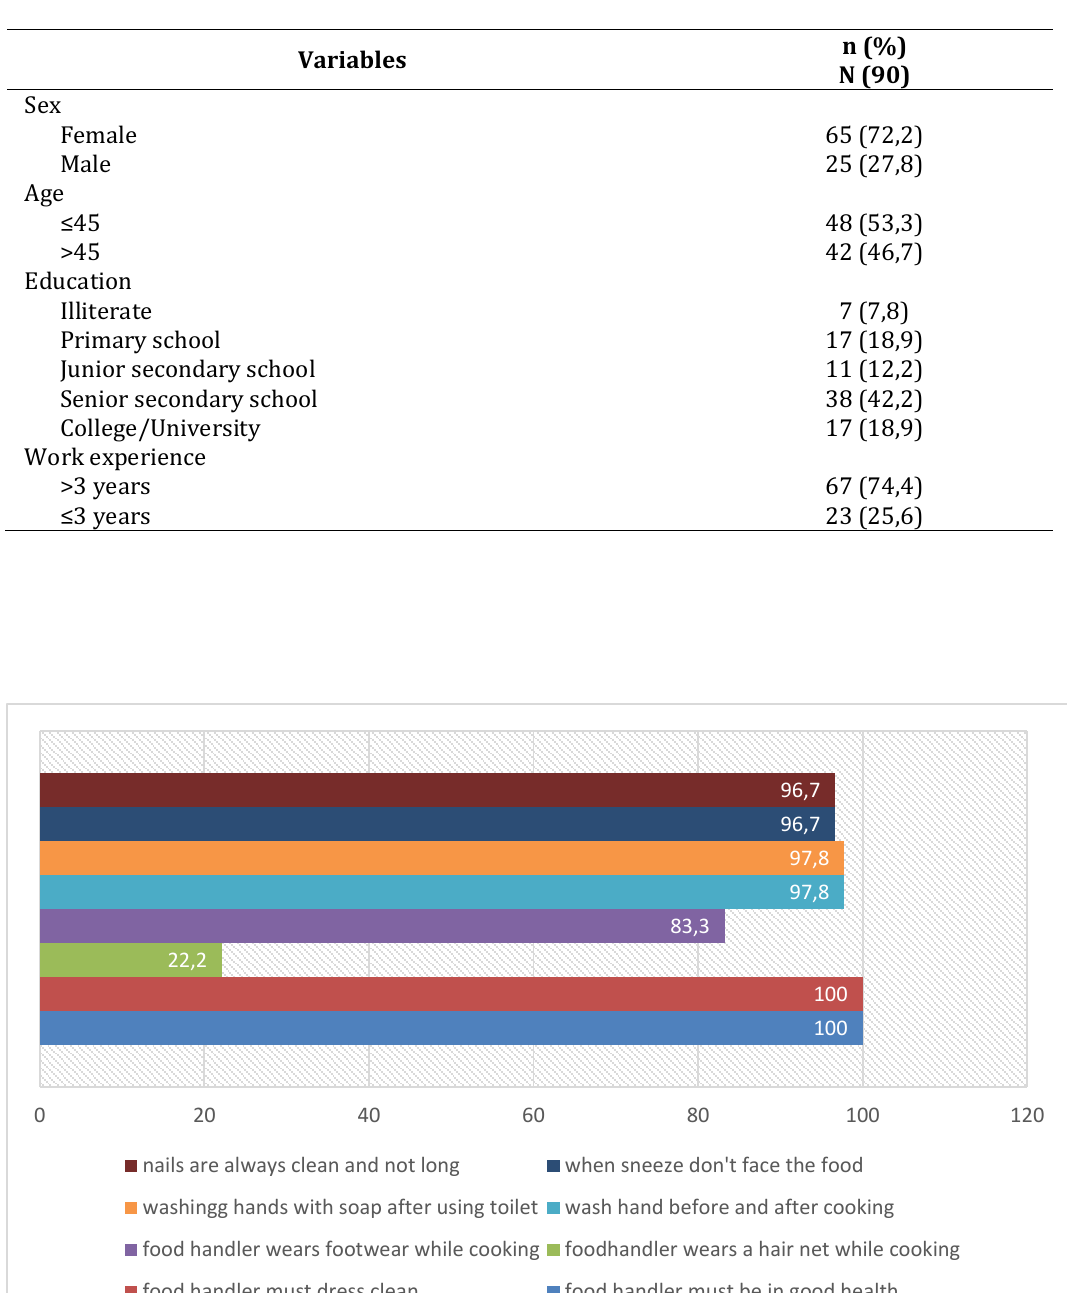
Socio-demographic characteristics of food handler